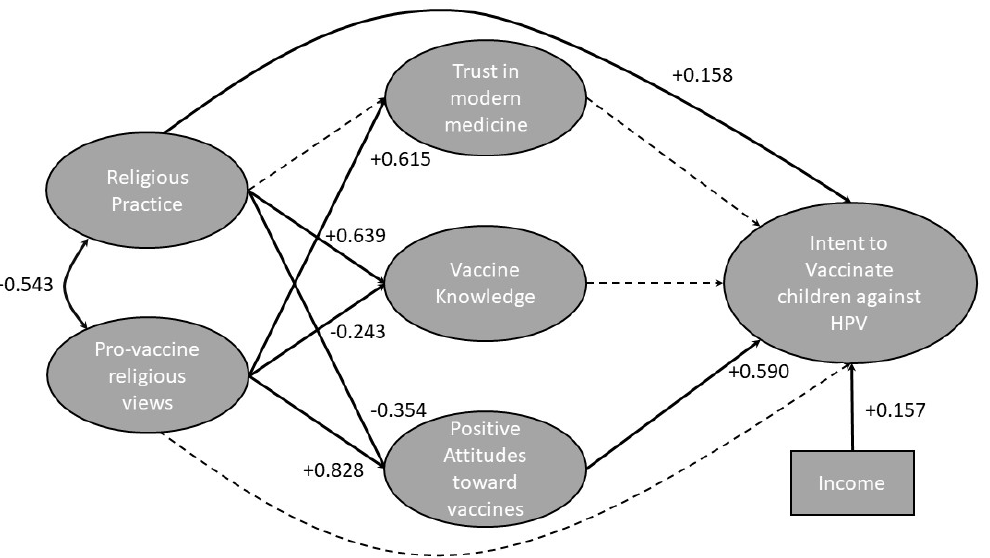
Figure 2. Results of structural equation model A. We hypothesize that religious practice and pro- vaccine religious views affect trust in modern medicine, vaccine knowledge and positive attitudes toward vaccines, which in turn affects parents’ intent to vaccinate against HPV. Bolded lines indicate the relationship is significant, the numbers adjacent to the lines indicate the strength and direction of the relationship. The biggest influence on intent to vaccinate is positive attitudes toward vaccines (+0.590), which is negatively influenced by religious practice ( − 0.354) and positively influenced by the views of respondent’s religion toward vaccines.